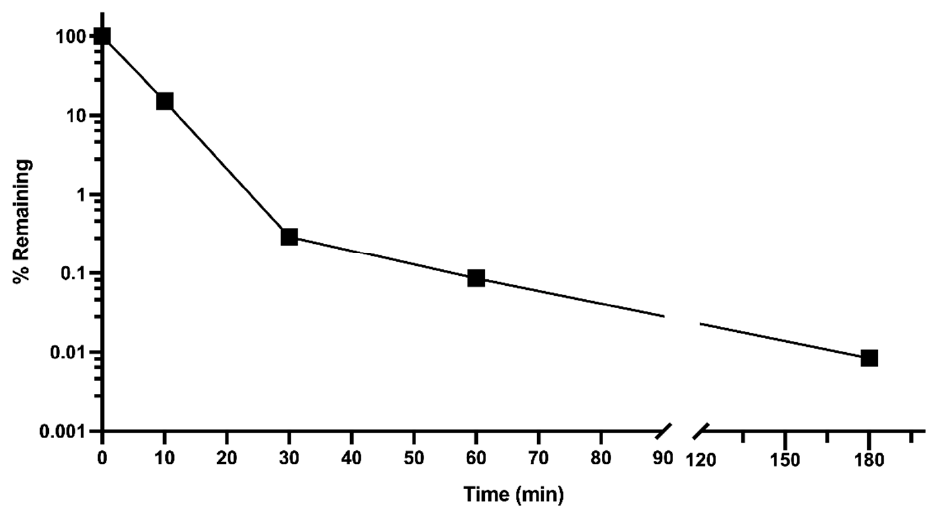
Table 2. In vivo observation after GKB202 compound supplementation in different dosage.